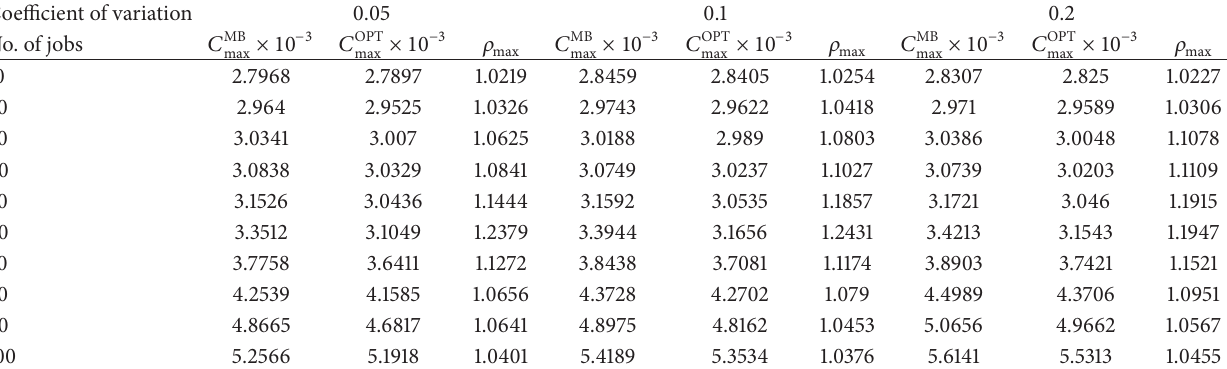
Table 6: The performance of the proposed algorithm versus lower bound of optimum.